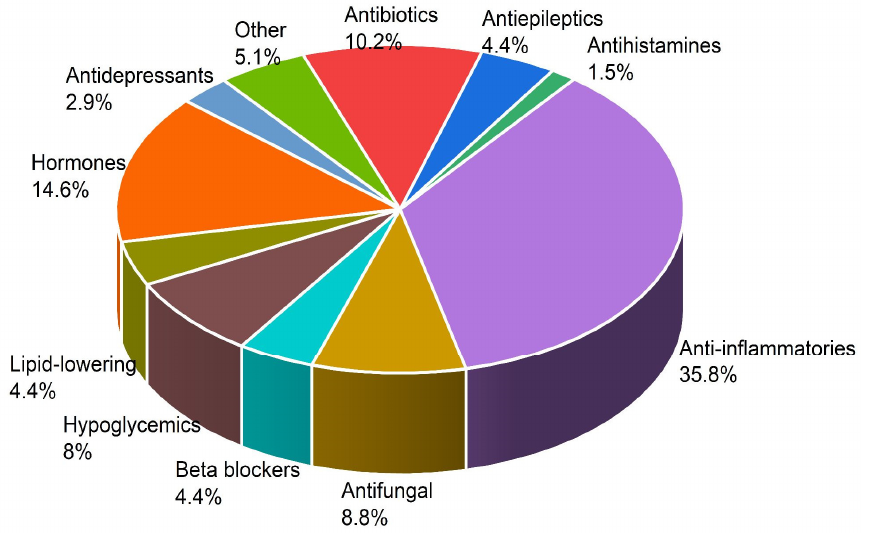
Figure 3. Figure 3. Percentages of different pollutants found in Mexico City and the metropolitan area (2013– 2023) [14–16,27–33].